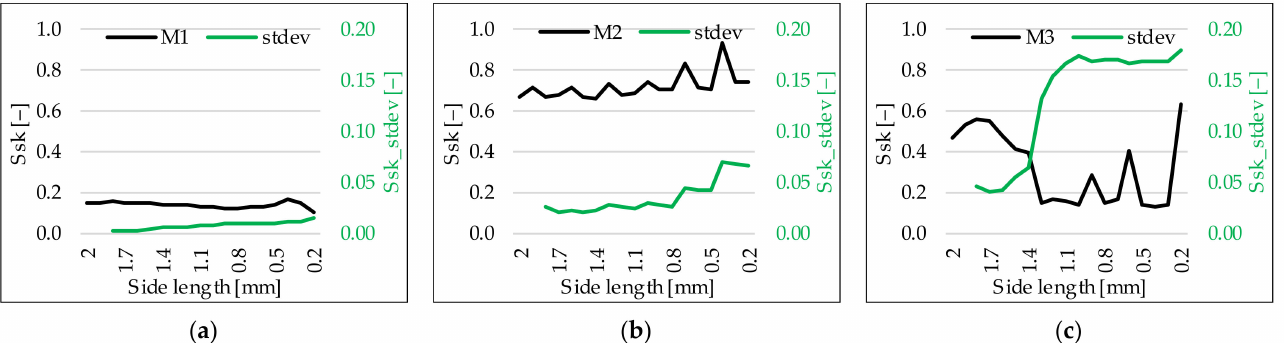
Figure 6. Ssk parameters (black) and their standard deviations (green) as a function of the analyzed area (2 × 2 mm–0.2 × 0.2 mm): ( a ) M1—hard turning, f = 0.1 mm/rev; ( b ) M2—hard turning, f = 0.3 mm/rev; ( c )